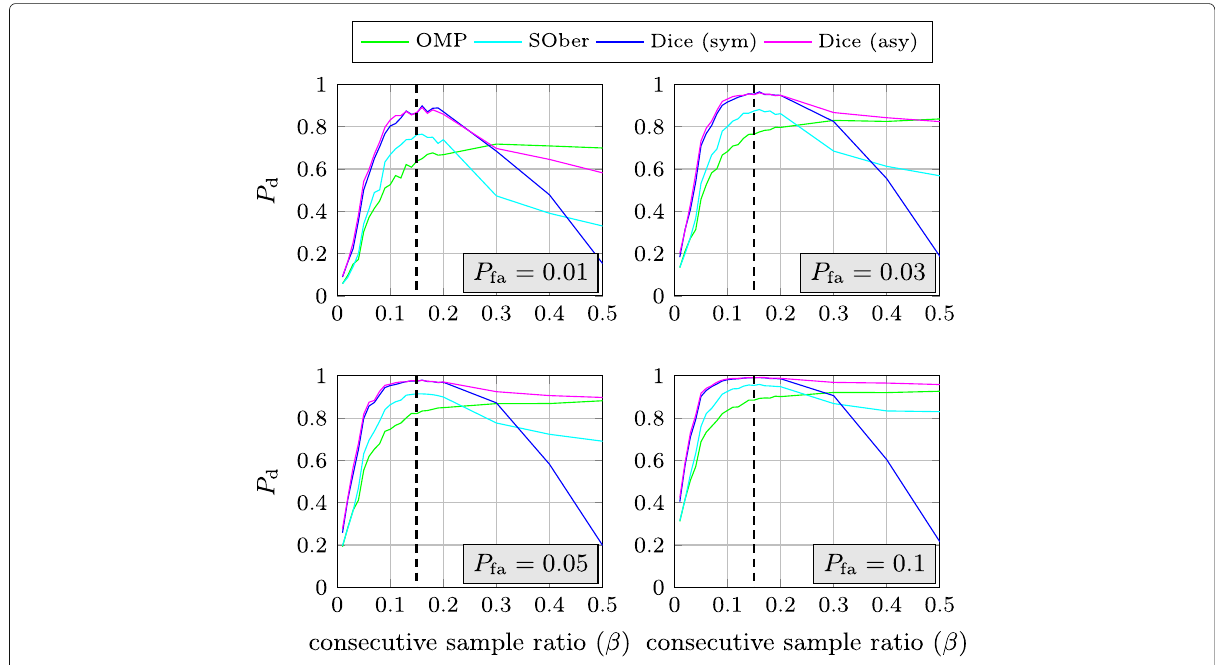
Fig. 1 Detection rate over consecutive sample ratio for different false alarm rates at 0 dB SNR for the OMP, a high β is no good choice regarding other performance categories.